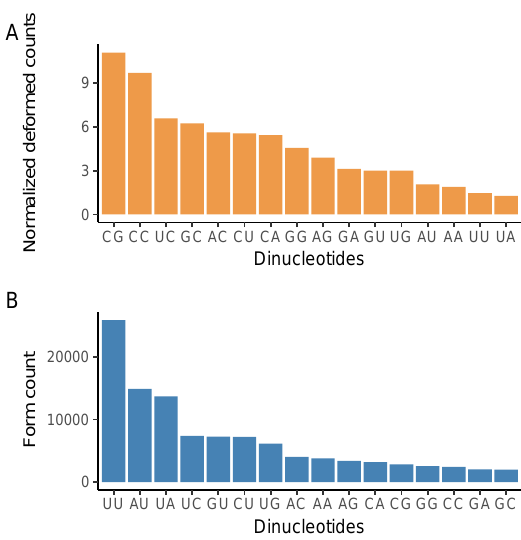
Figure 4. Comparison of dinucleotide formations and deformations retrieved from phylogenetic trees. Deformation ratio of dinucleotides is represented as the ratio of deformation count in the tree over dinucleotide’s abundance in the reference genome ( A ). As a result of the mutations, the relative dinucleotides are formed ( B ).